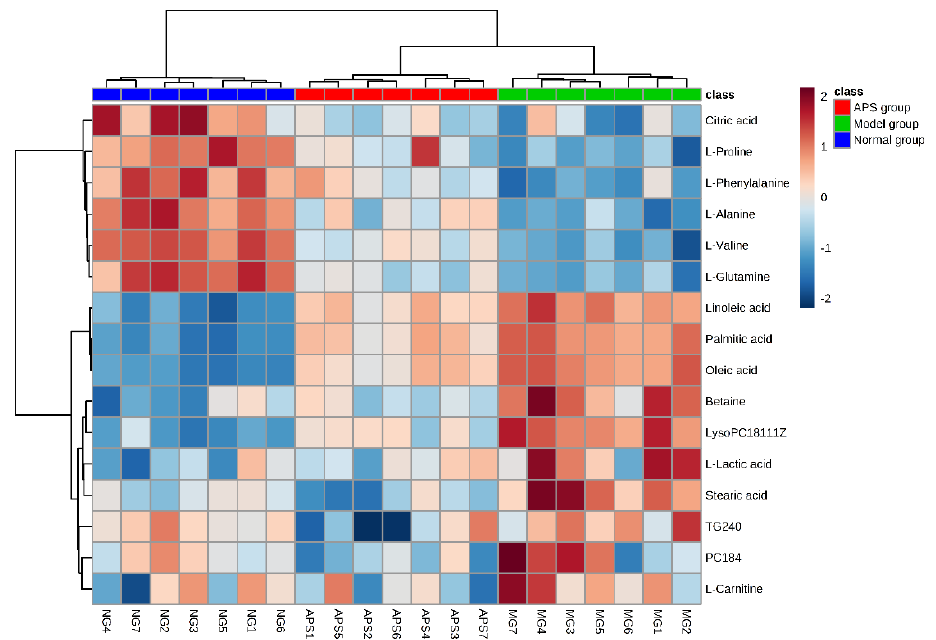
Figure 4. Heat map of the 16 differentially produced endogenous metabolites between the normal group, model group, and APS group. Orange plots indicate up-regulated metabolites, and blue plots indicate down-regulated metabolites in rats.